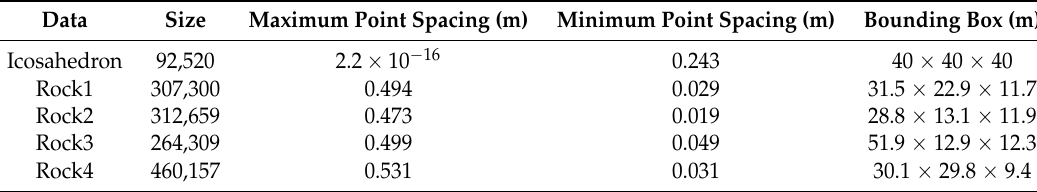
Table 1. Basic information of point